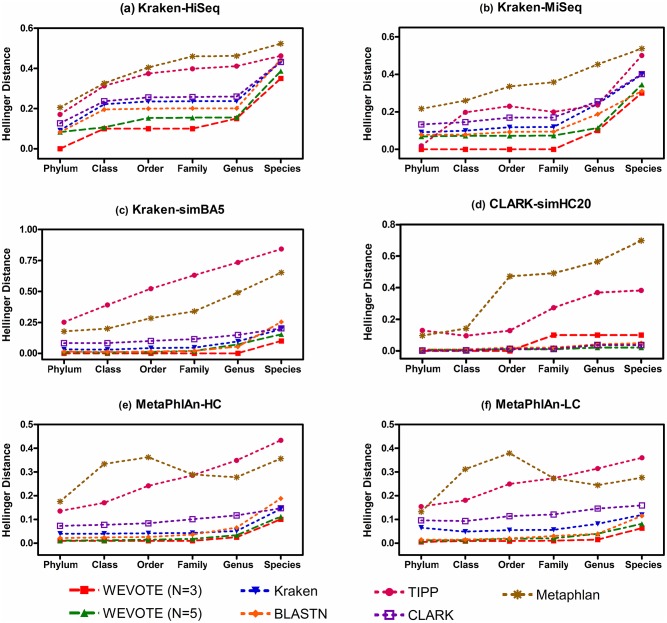
The Hellinger distance.The deviation between the predicted and the true abundance profile was measured in terms of the Hellinger distance for each tool at different taxonomic levels. Results are shown for: (a) Kraken-HiSeq dataset; (b) Kraken-MiSeq dataset; (c) Kraken-simBA5 dataset; (d) CLARK-simHC20; (e) MetaPhlAn-HC and (f) MetaPhlAn-LC. The lower the error, the more precise the corresponding tool is at the corresponding taxonomic level. H = 0 means that the predicted relative abundance profile is exactly the same as the true profile; while H = 1 means that the predicted profile is completely different from the true profile.